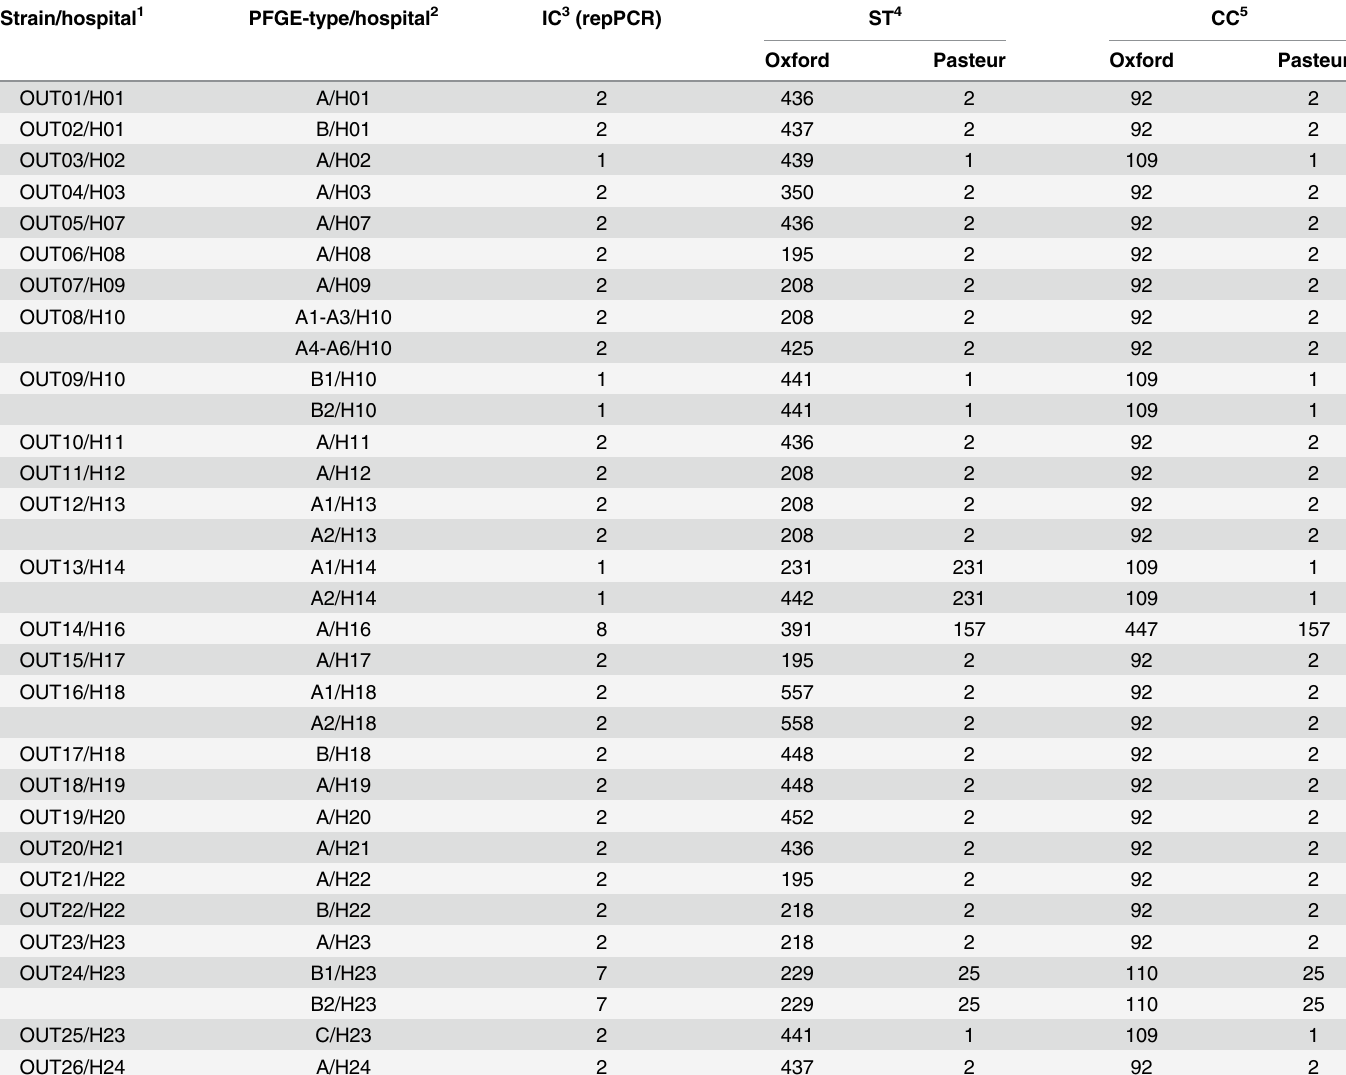
Table 1. Epidemiological characterization of 26 outbreak strains using PFGE, rep-PCR, and MLST. Strain/hospital